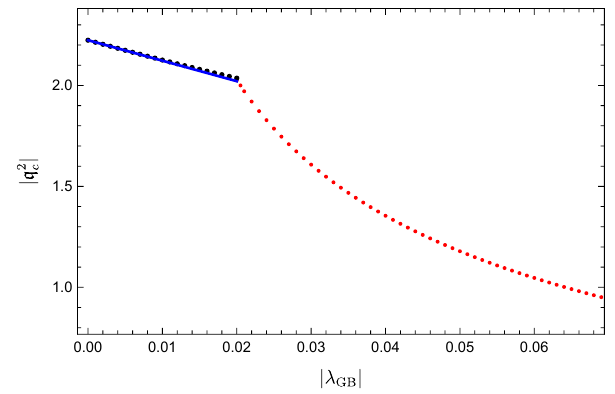
Figure 13 . Radius of convergence of the hydrodynamic shear mode in the Einstein-Gauss-Bonnet theory as a function of the higher-derivative coupling λ ( λ < 0 ). The blue line is the pertur- GB GB bative result (4.9). Black dots on top of the blue line denote the radius of convergence computed non-perturbatively in λ (see figure 11, top left panel). The red dots correspond to the critical GB point involving the shear mode and the non-perturbative mode (see figure 12, top left panel). The transition between the two regimes occurs at λ ≈ − 0 . 0198 . GB